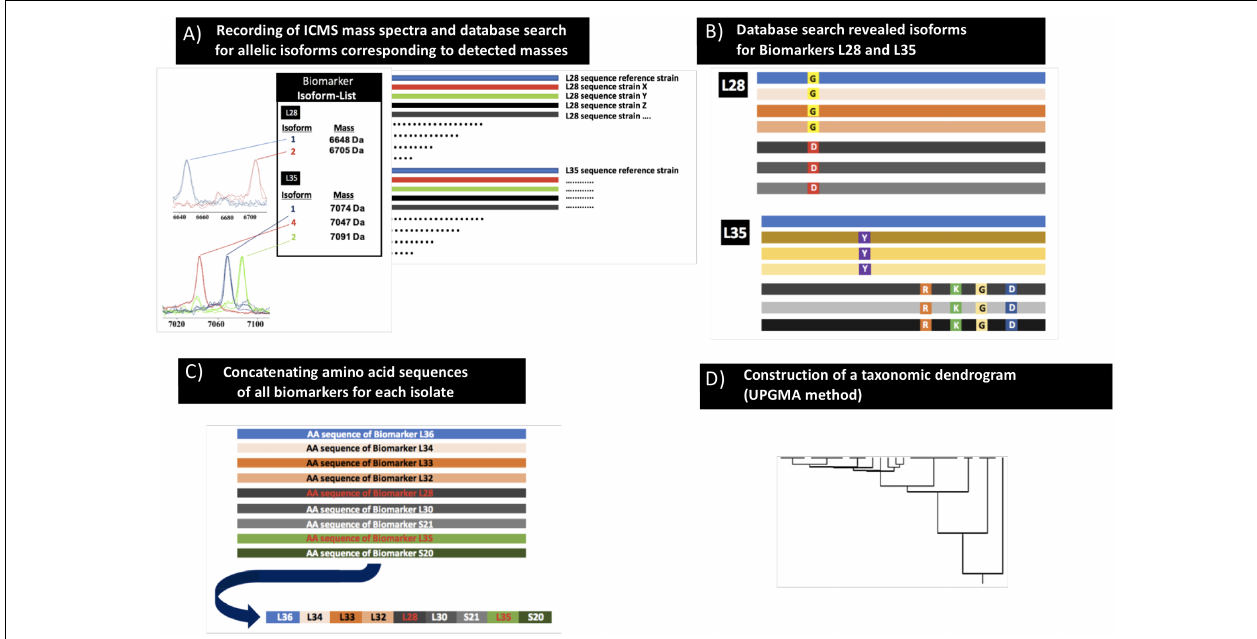
FIGURE 1 | Scheme of the proteotyping workflow. (A) Recording of MALDI-TOF mass spectra of C. difficile isolates (extracts as well as smear preparation). (B) Identification of allelic isoforms by comparison with the allelic isoform database that contains the sequence data of the C. difficile genomes deposited in public databases. (C) Assembly of the concatenated amino acid sequences of the respective isoforms to one continuous sequence. (D) Calculation of a taxonomic proteotyping-derived UPGMA dendrogram.